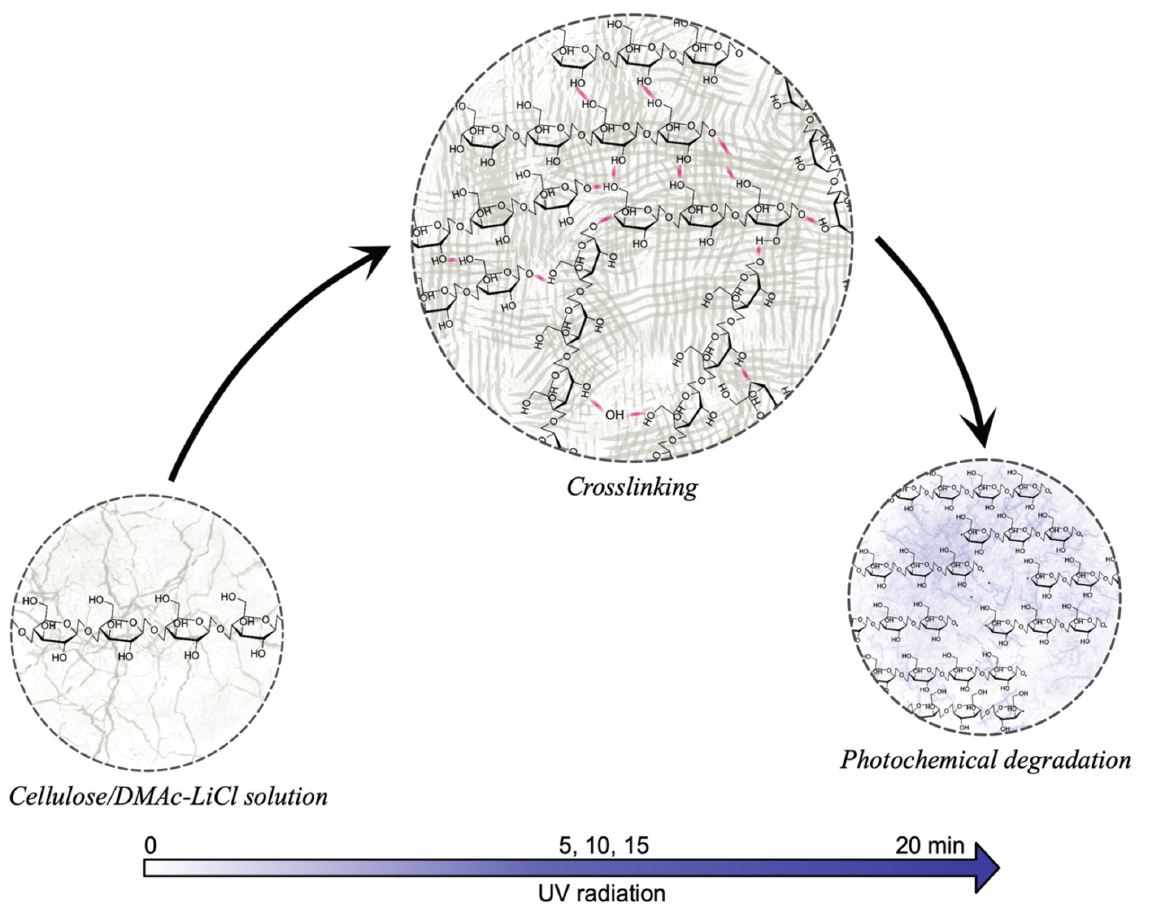
Figure 6. Effect of UV radiation on cellulose in DMAc/LiCl solution. At times greater than 20 min, the photochemical degradation exceeds the crosslinking reactions; this being reflected in the decrease in mechanical properties.